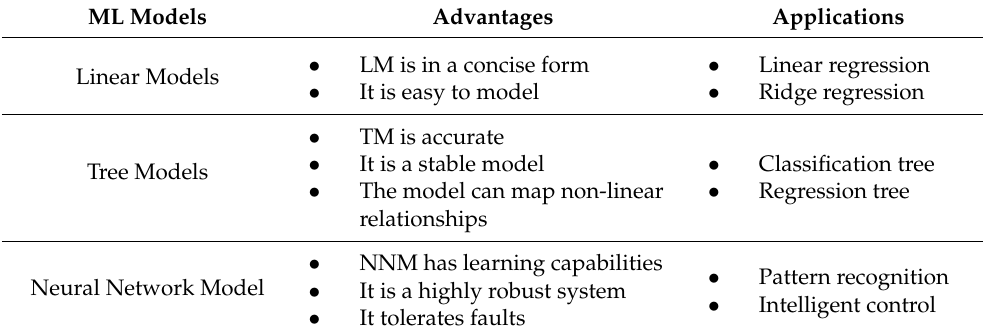
Table 5. Summary of Applicable Machine learning Methods.